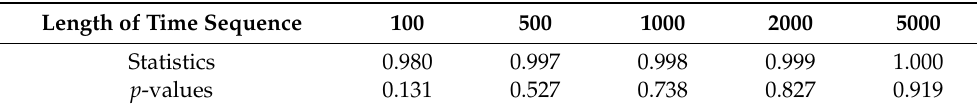
Table 2. The SW Test on the C Difference Time Sequence.